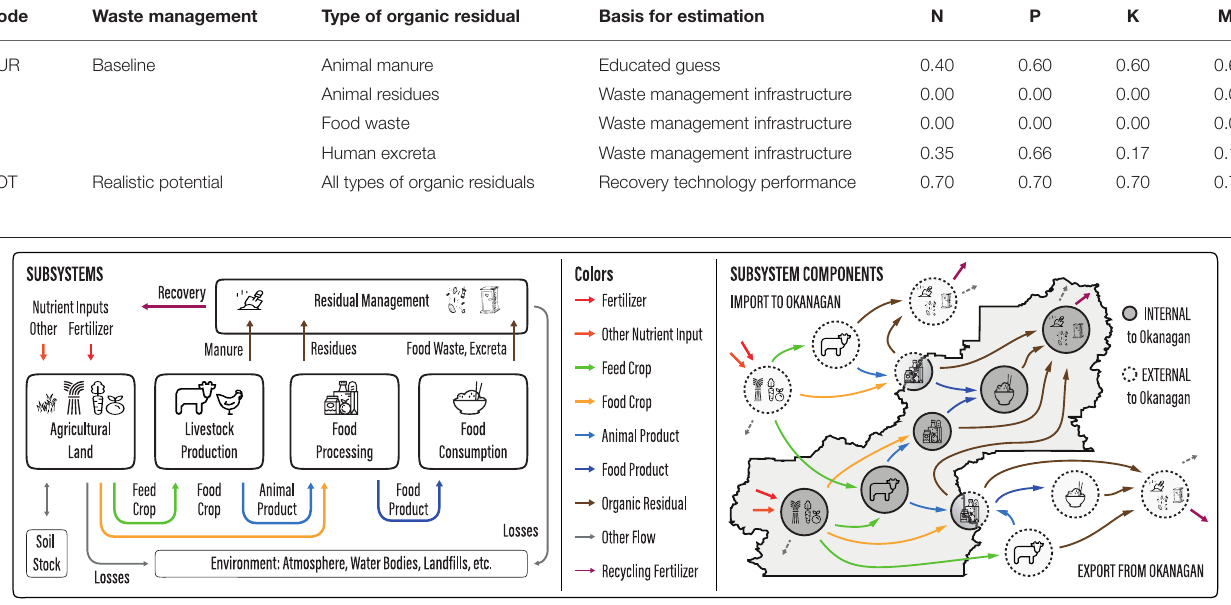
TABLE 2 | Recovery and reuse ratios for various organic residuals, for the year 2016 baseline and one scenario for 2050 that represents a realistic recovery potential.